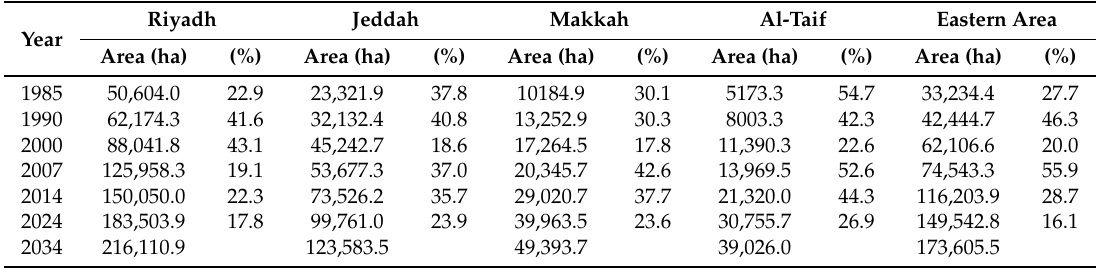
Table 6. Absolute urban growth (in ha) between 1985 and 2014 and for the expected growth for the years 2024 and